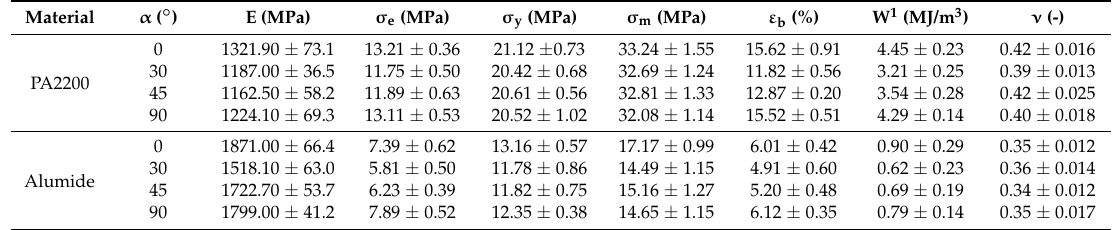
Table 2. Tensile mechanical properties of investigated PA2200 and Alumide porous materials